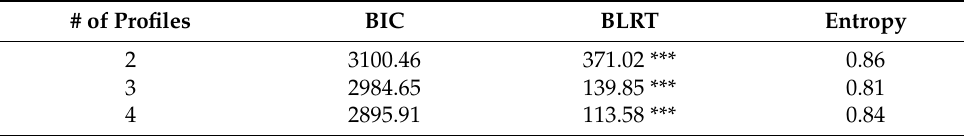
Table 4. Fit indices for the latent profile analysis (LPA)